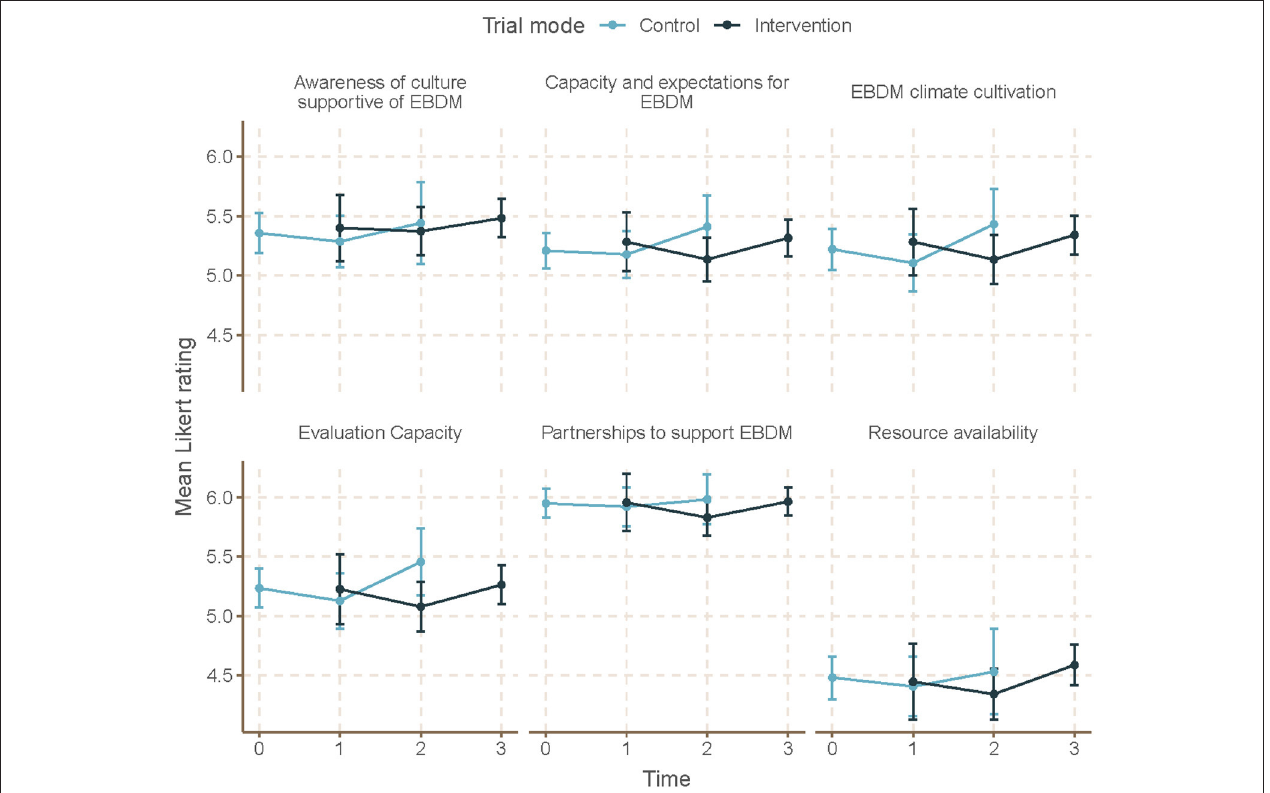
FIGURE 5 | Mean EBDM culture items by time and trial mode. At each time point, mean and 95% confidence intervals for organizational culture supportive of evidence-based decision making (EBDM) items are displayed for individuals during control and intervention phases. All items on organizational culture supportive of EBDM were measured on a 7-point Likert scale. A summary score was created as an average of the items within each domain. Time 0 represents baseline where all units (local health departments) were in control period. Time 3 is the final data collection point and all individuals are in intervention period. Total mean skills gap score was created as an average of the 10 individual competency